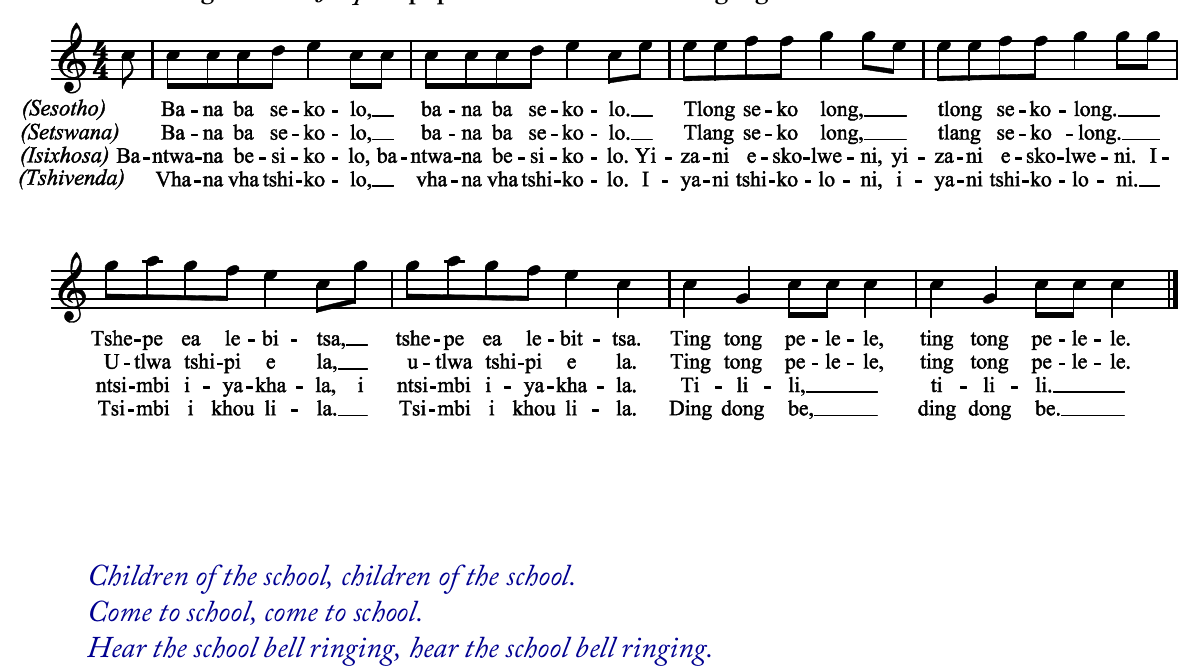
Fig. 4. Frère Jacques: popular form in African languages in South Africa